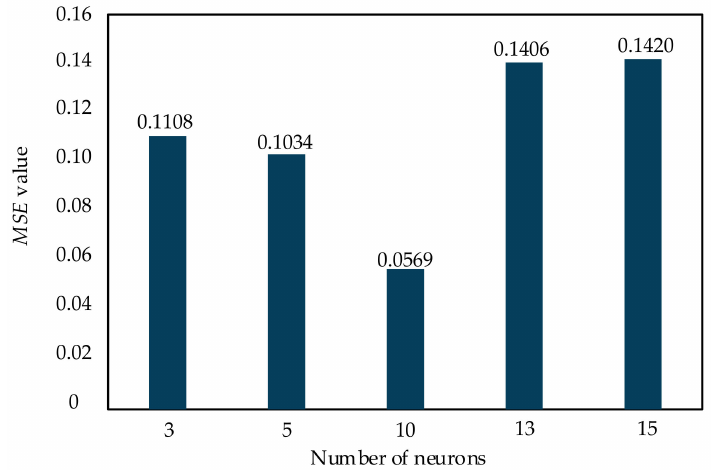
Figure 6. MSE values of phase selection under different neurons number.